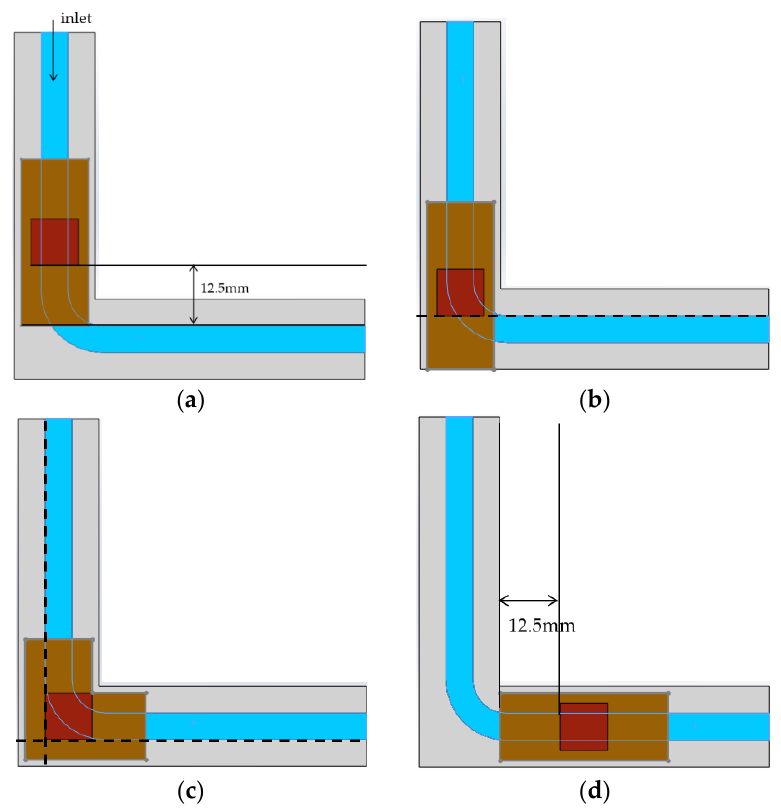
Figure 4. Schematic diagram of positional relationships between heat source and bend: ( a ) in front of the bend; ( b ) near the bend; ( c ) just above the bend; ( d ) behind the bend.